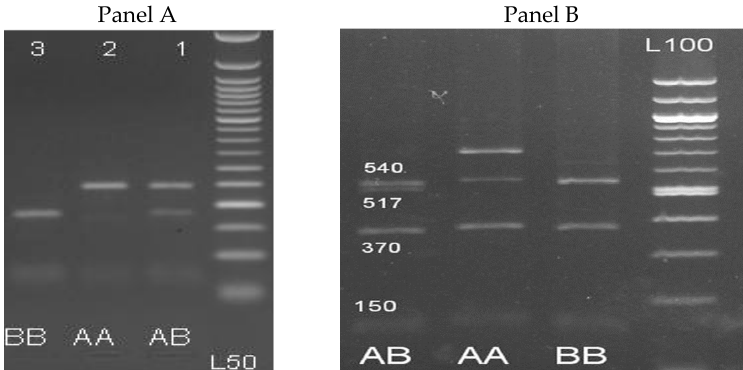
Figure 1. PCR-RFLP results for β -LG ( A ) and prolactin ( B ) genes using RsaI and HaeIII restriction enzyme respectively on 3% agarose gel. Panel A: Lanes 1, 2 and 3 are: AB (241, 175, 66 and 60 bp), AA (241 and 60 bp), and BB (175, 66 and 60 bp) genotypes, and L50: Ladder 50bp. Panel B: Lanes 1, 2 and 3 are: BB (517, 370, 147, and 151 bp), AA (540, 370, 147, and 151 bp), and AB (540, 517, 370, 147, and 151 bp) genotypes, and L100: Ladder 100 bp.